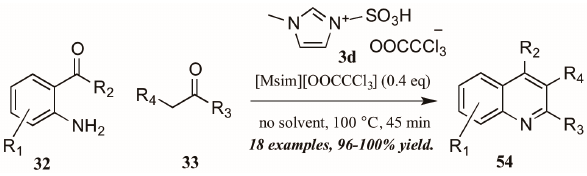
Figure 24. Ionic liquid-catalyzed Friedländer quinoline synthesis.